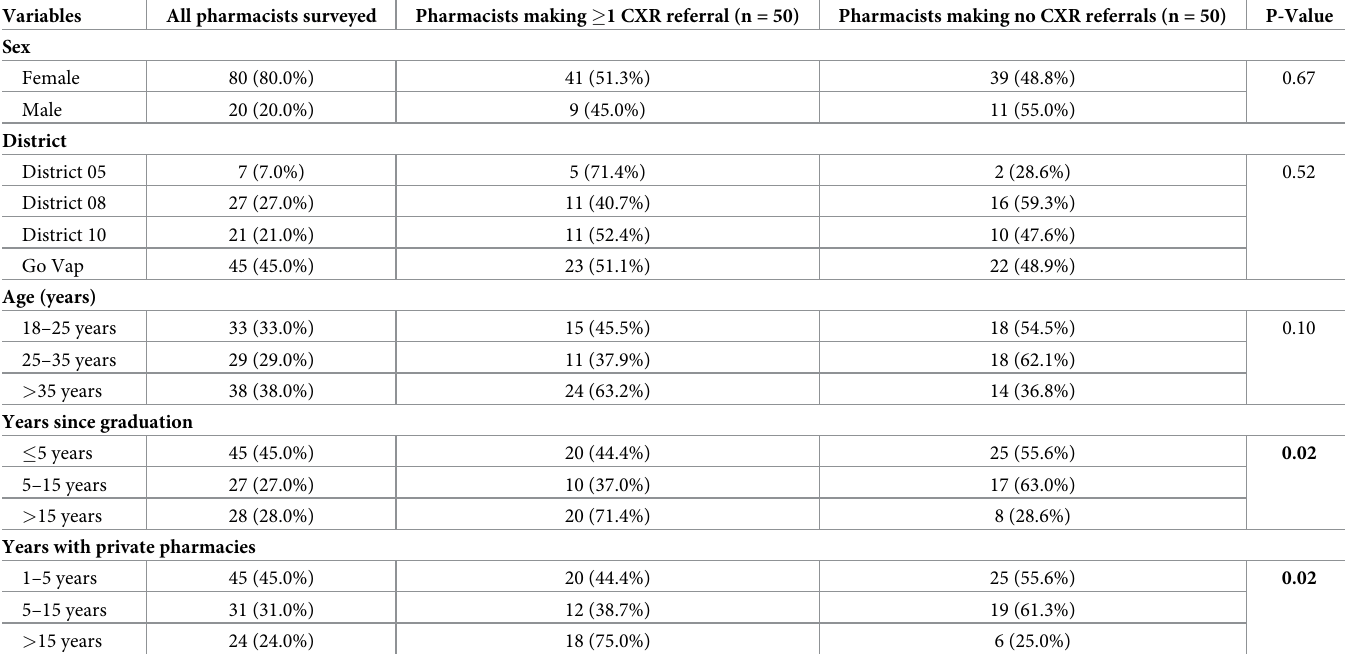
Table 3. Characteristics of surveyed pharmacists, stratified by their referral